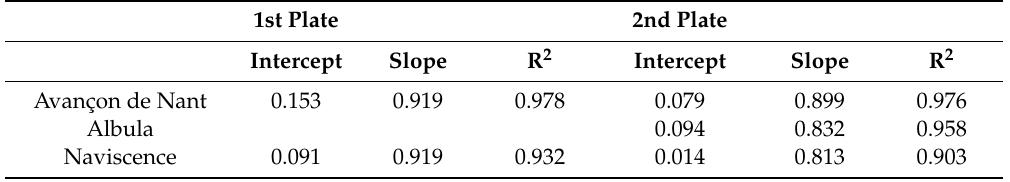
Table 7. Regression coe ffi cients between the impact A max and the associated energy propagation at one and two plates of distance recorded for all the impacts on every plate taken together at a given measuring site. 1st